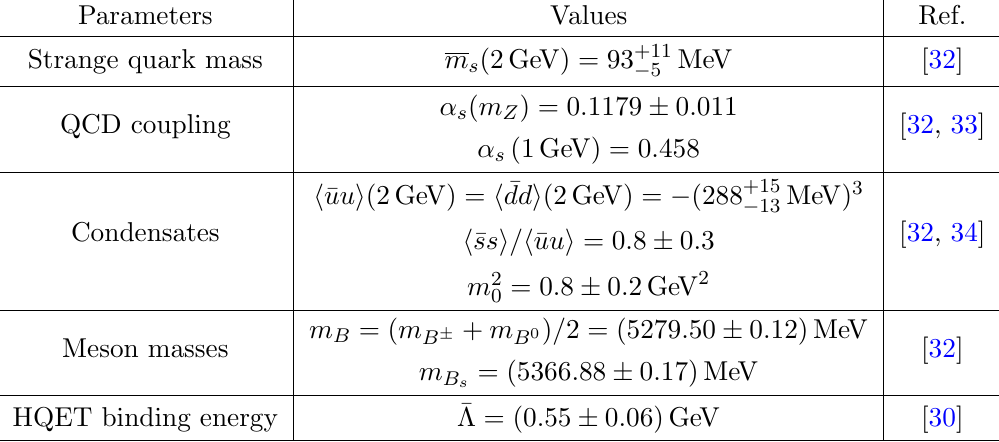
Table 1 . Values of the input parameters used in the numerical